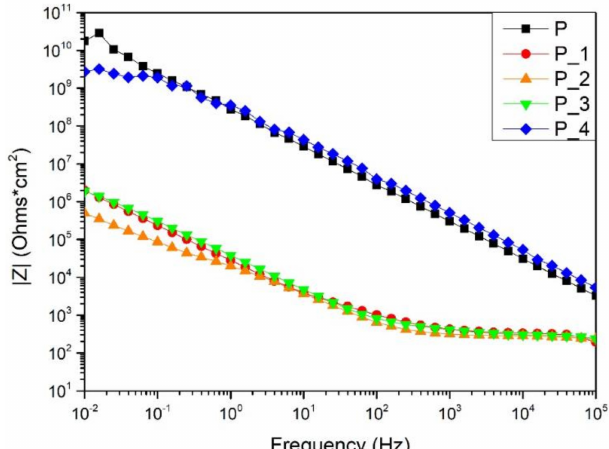
Figure 6. Bode impedance modulus of sample P series before the pack test and after 24 h of exposure in the di ff erent test environments.